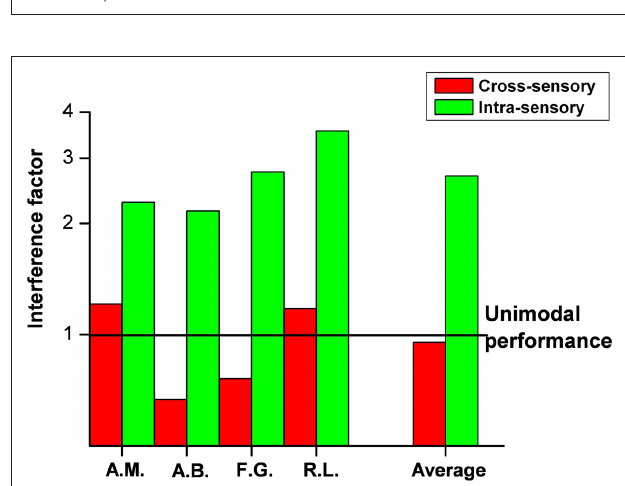
Figure 3 | Subject performance on the secondary task, either auditory (red bars) or visual (green bars). The interference factor is defined as the ratio between dual-task and single-task thresholds (a value of one meaning no interference between